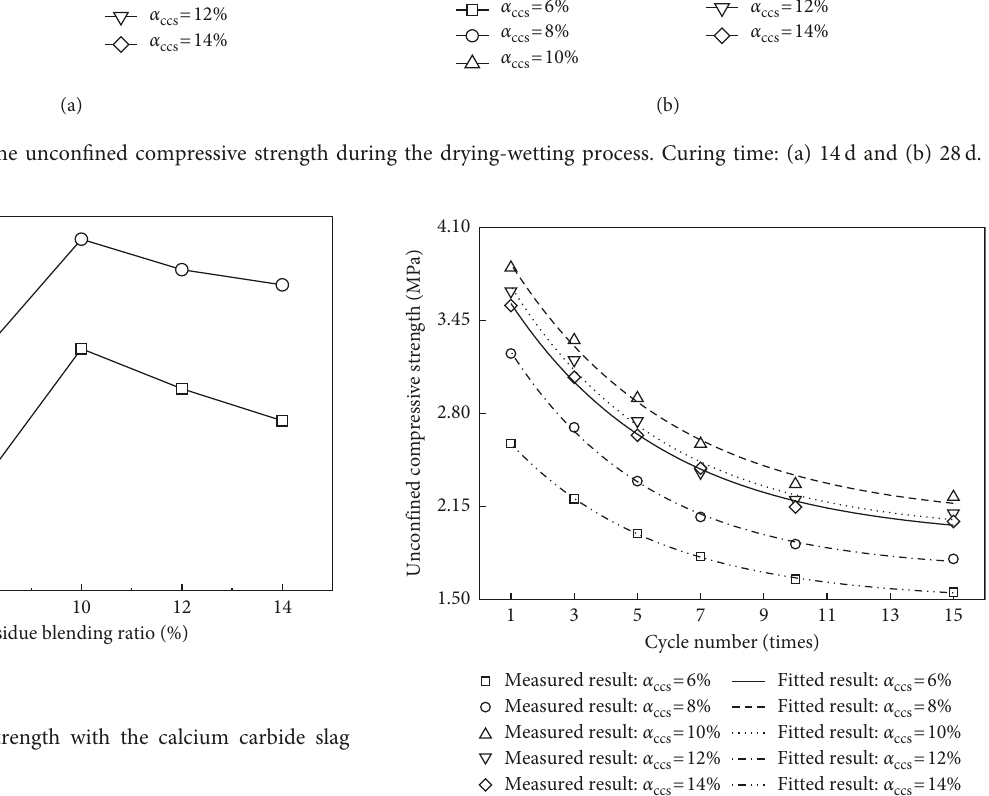
Figure 8: Relationships between the unconfined compressive strength and the number of drying-wetting